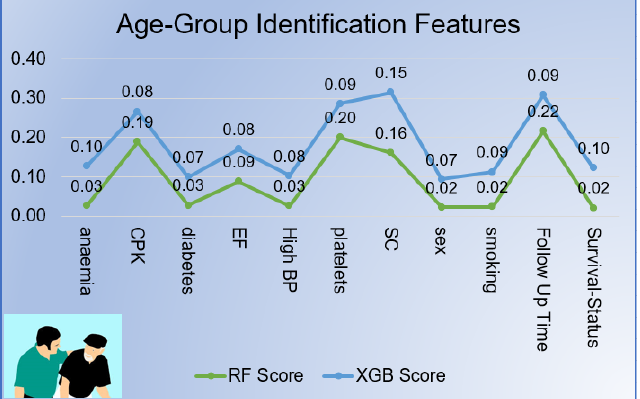
Figure 10. Patient Age group Features.